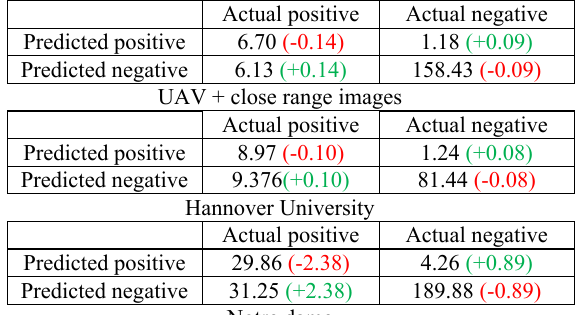
Table 3. Derived Confusion Matrices (values in brackets indicate differences to VocMatch results)